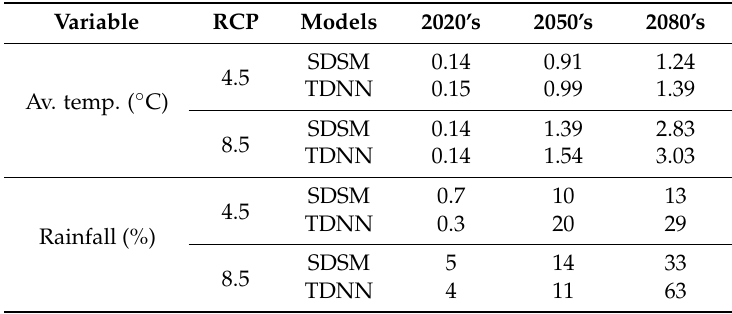
Table 4. Future projections of increase in average temperature and